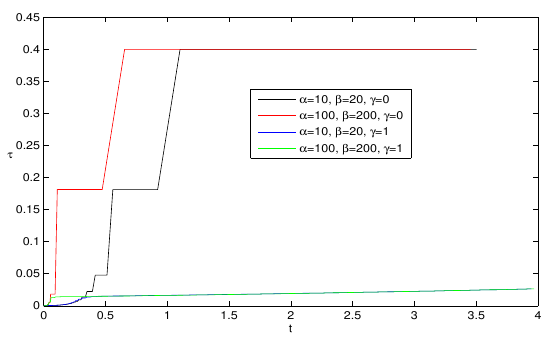
interval [0 , 4]. In Figure 1 the solutions of problem (6.1) are shown for different values of γ .